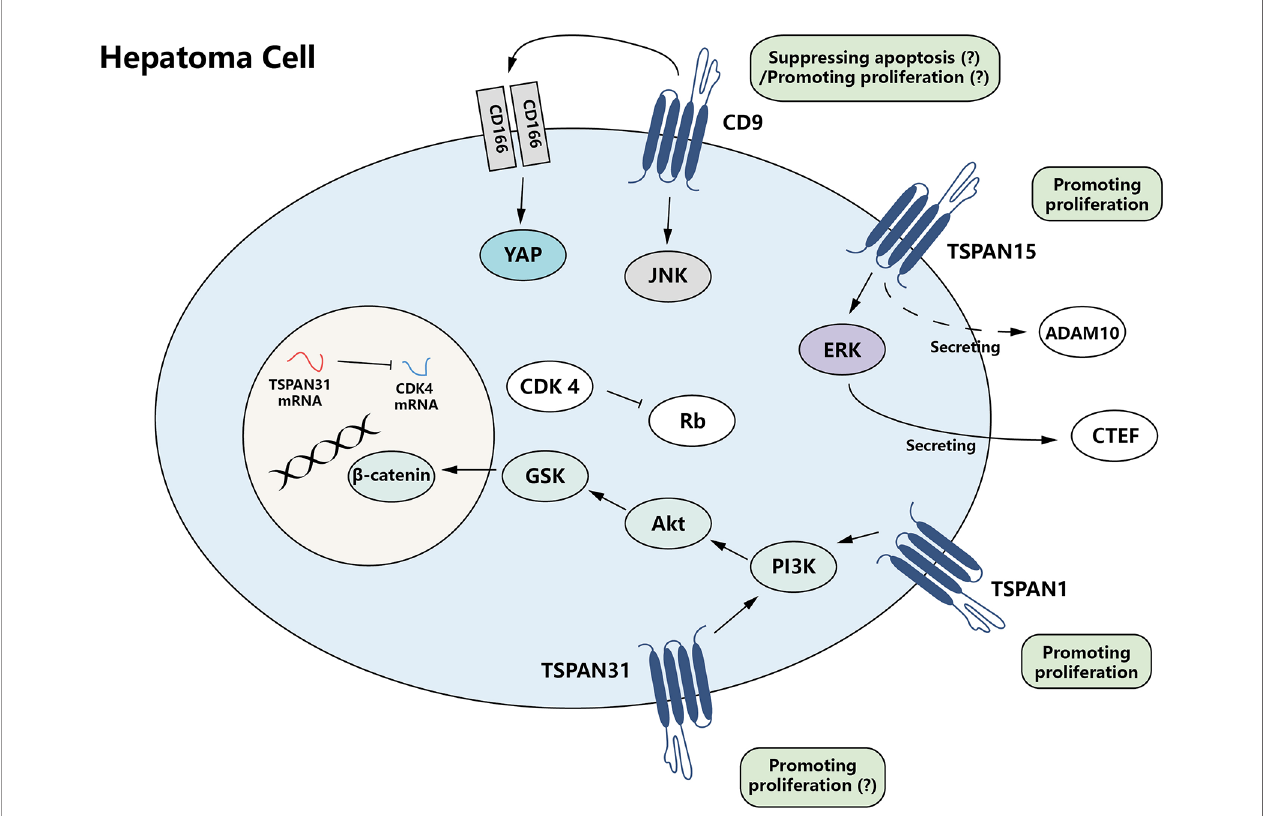
FIGURE 1 | The growth promotion effect of tetraspanin protein family for hepatoma cells. CD9, TSPAN15, and TSPAN31, members of the tetraspanin family, are able to mediate proliferation-promoting and apoptosis-suppressing signals directly or indirectly, which results in modulation of tumor cell